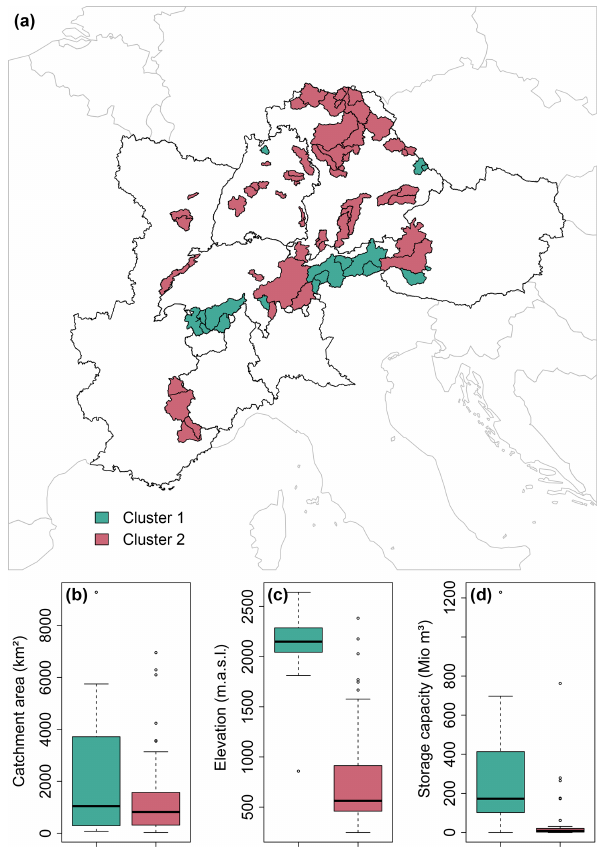
Figure 9. Two groups of catchments with distinct reservoir regula- tion signals, where panel (a) shows catchments belonging to clus- ters 1 (turquoise) and 2 (red) with similar seasonal regulation pat- terns (see Fig. 8). Panel (b) shows distributions of catchment areas for clusters 1 and 2, (c) distributions of elevations for clusters 1 and 2, and (d) distributions of reservoir storage capacities for clus- ters 1 and 2.